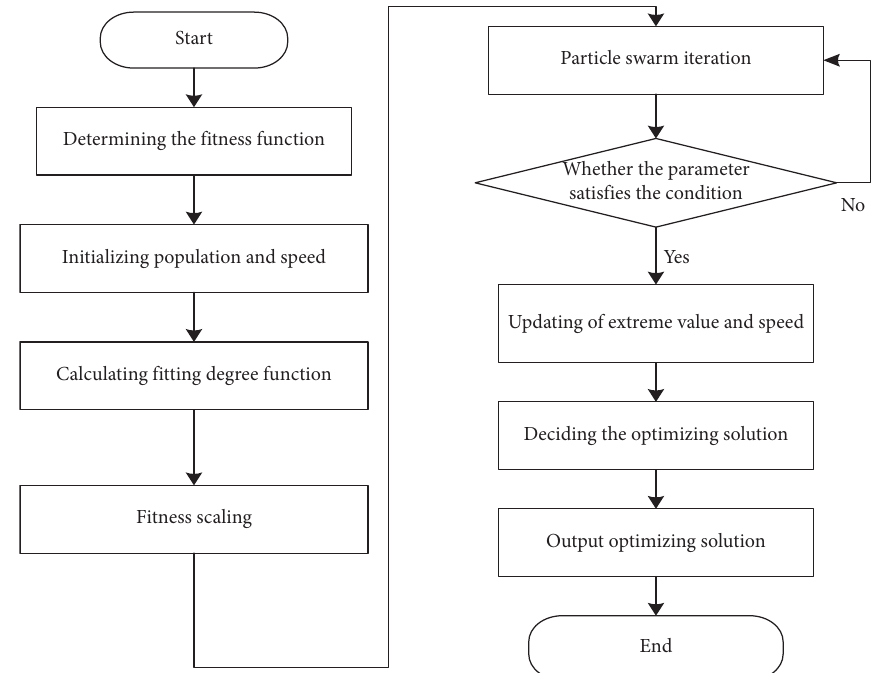
Figure 2: Flowchart of optimizing c and σ using PSO.